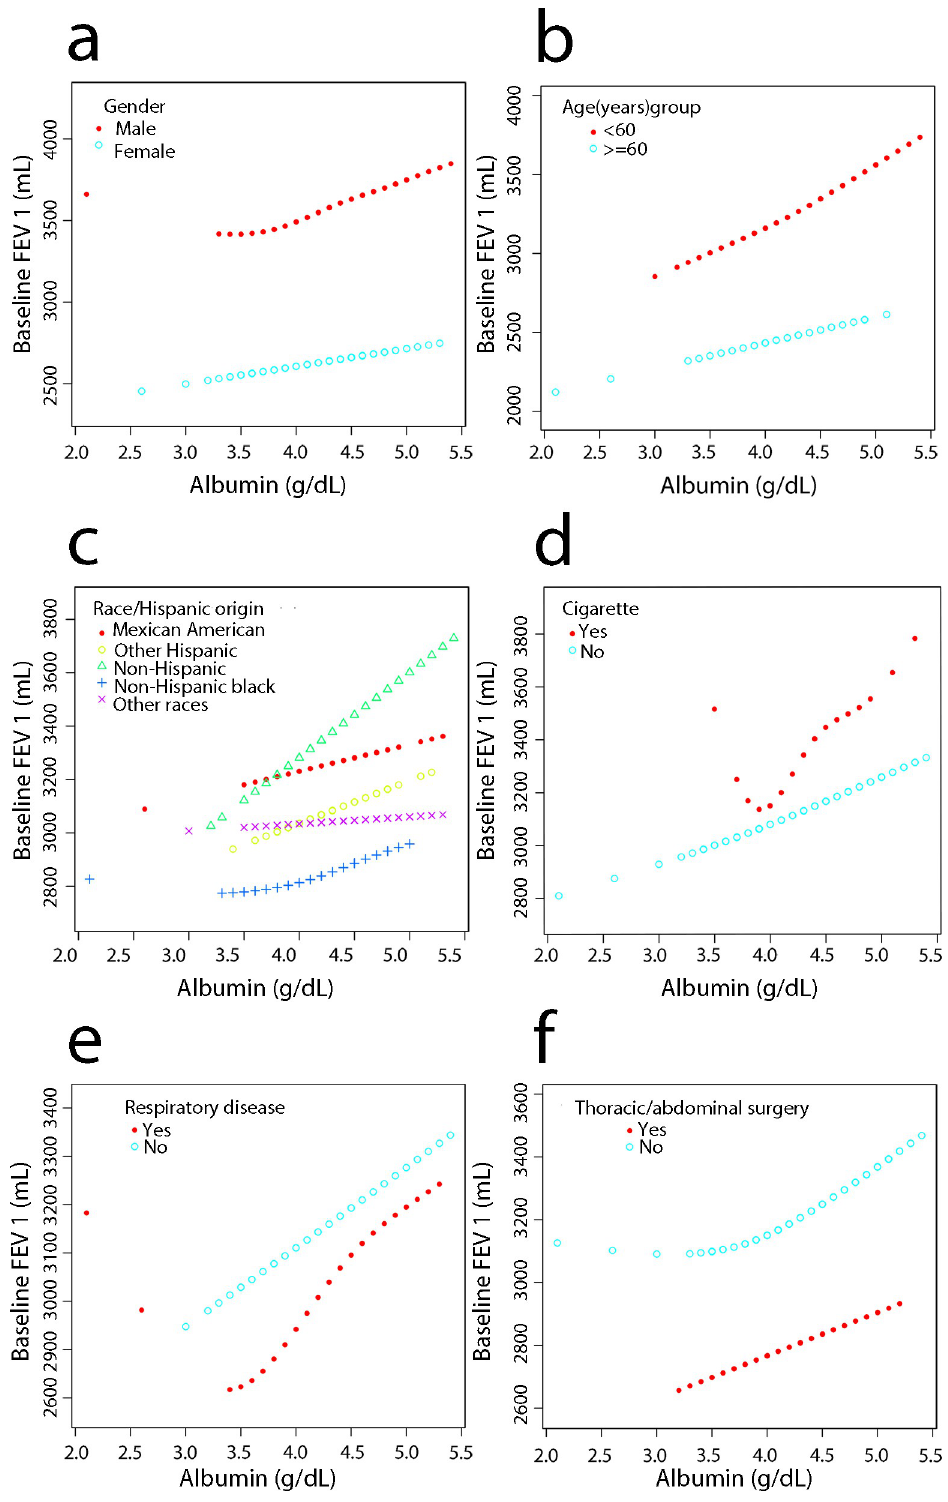
Fig 4. Relationship between serum albumin and FEV 1. (a) Stratified by sex. (b) Stratified by age. (c) Stratified by race. (d) Stratified by smoking status. (e) Stratified by respiratory disease. (f) Stratified by surgery.